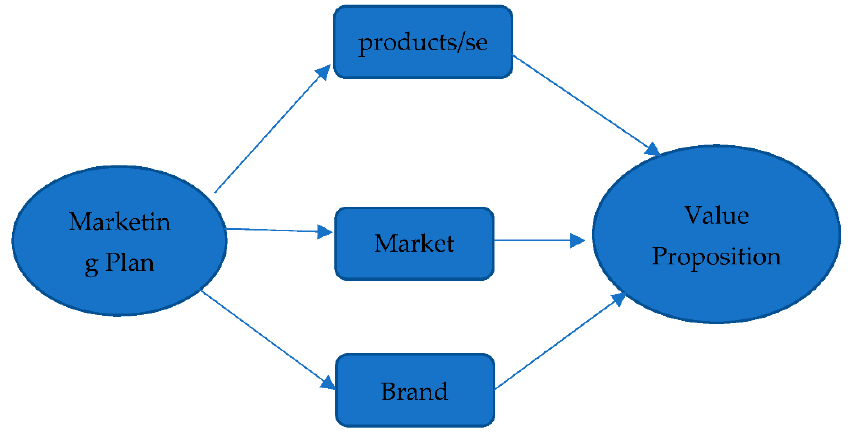
Figure 2. Value proposition development of UT.